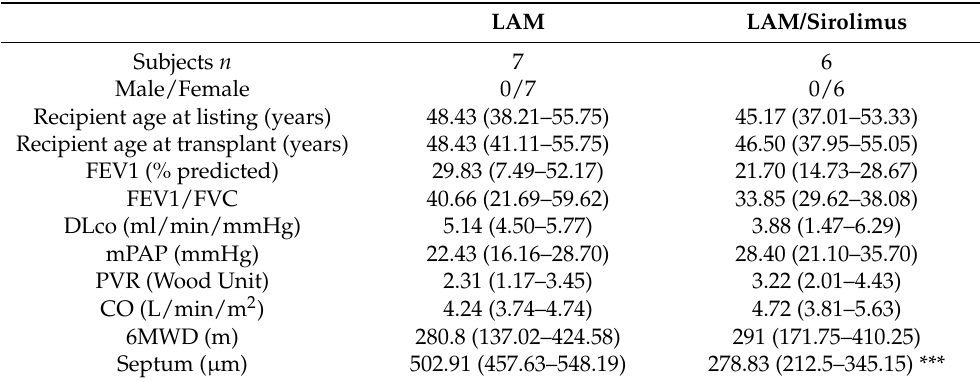
Table 1. Study population